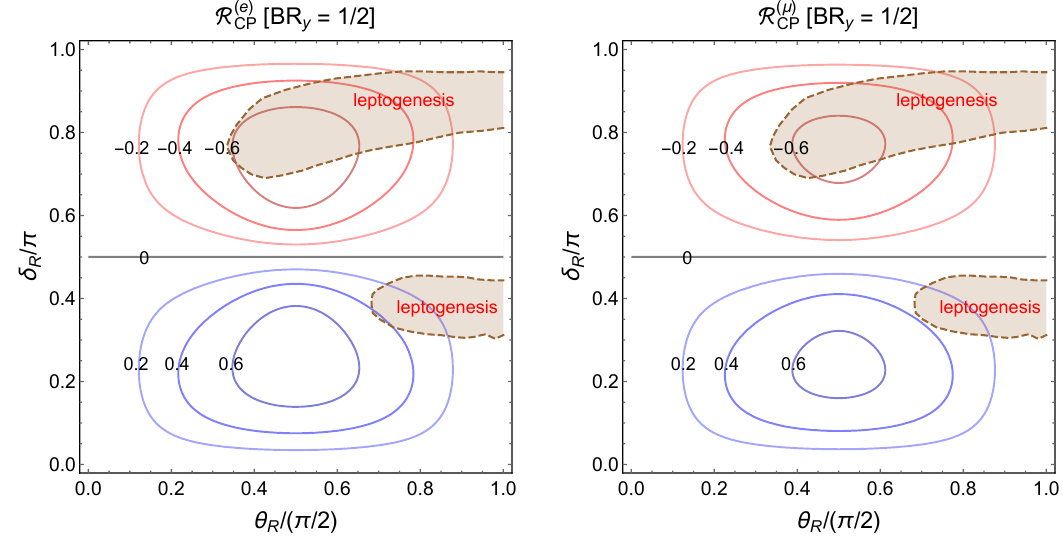
( e ) ( (cid:22) ) (left) and (right) as CP CP R R = 15 TeV. R